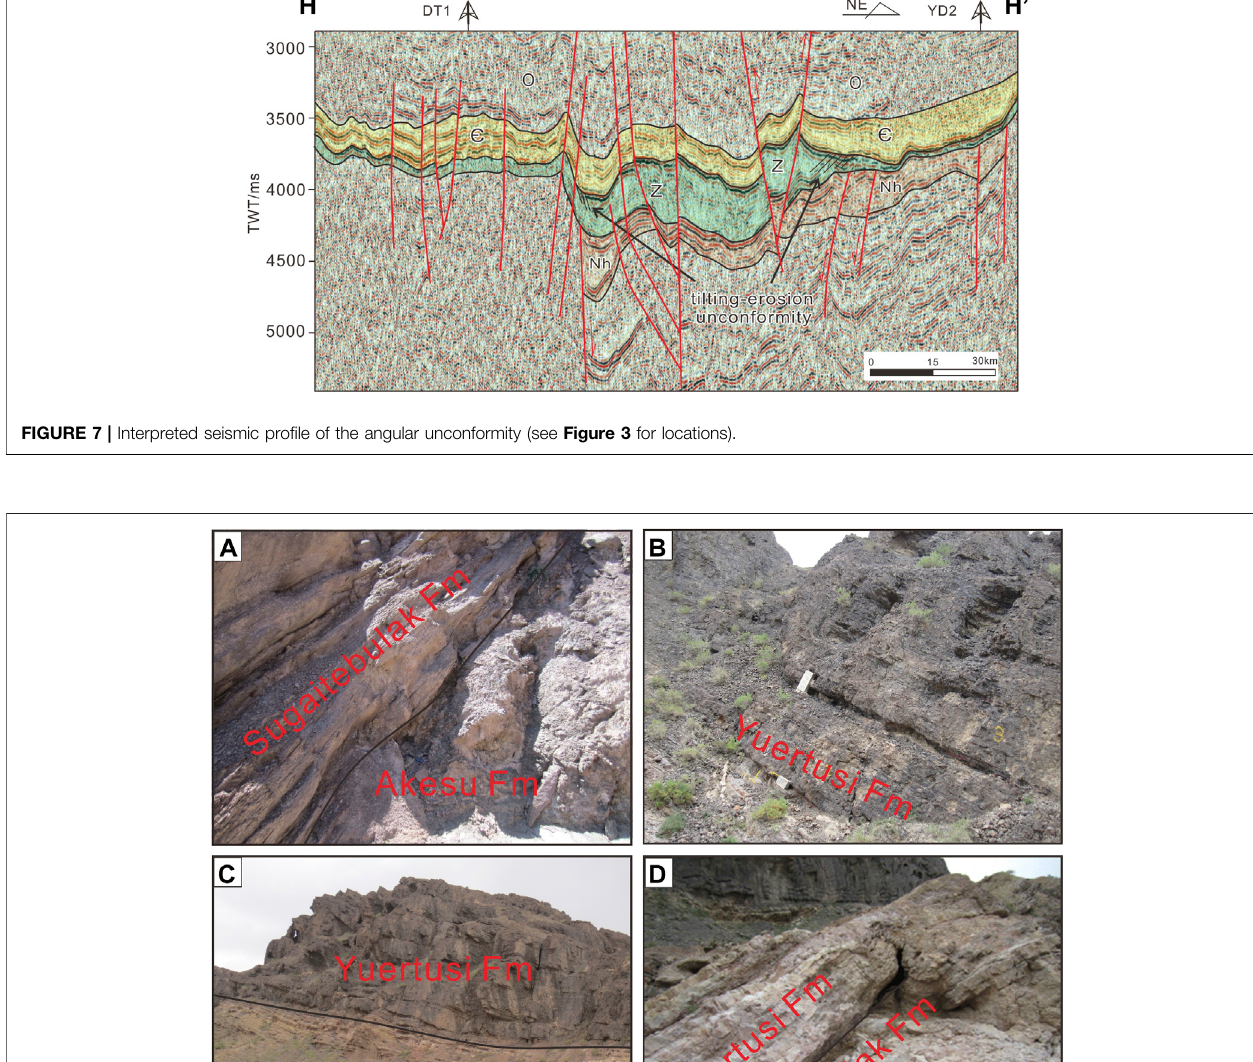
Frontiers in Earth Science |